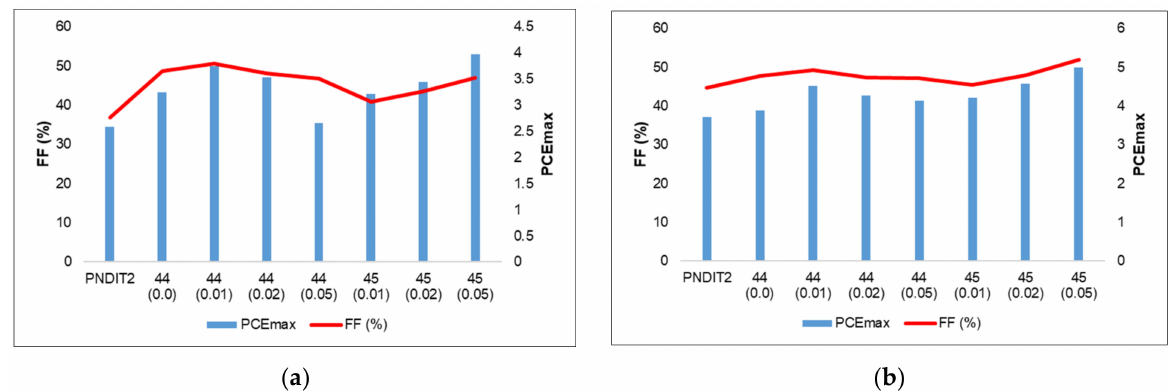
Figure 11. Variation of FF and PCE in ( a ) conventional (ITO/PEDOT:PSS/PTB7-Th: 44 – 45 /PDIN/Al) and ( b ) inverted (PTB7-Th: 44 – 45 ) cells with Pt(II) content. Value given in the parenthesis indicates certain amount (%) of Pt(II) cyclometa- lated